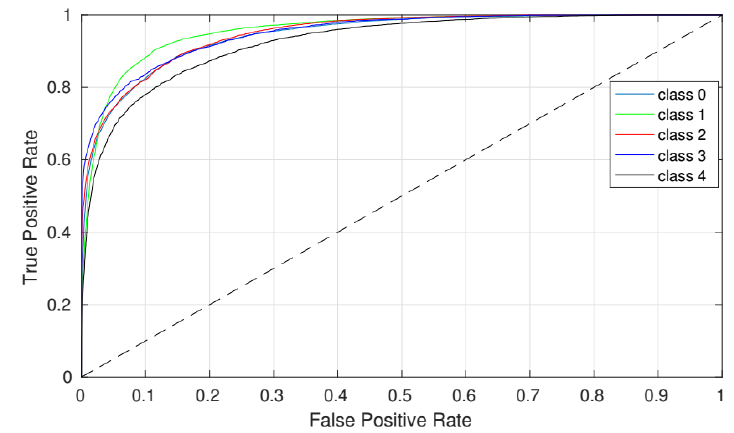
Figure 1. ROC curves for 5-class classification by